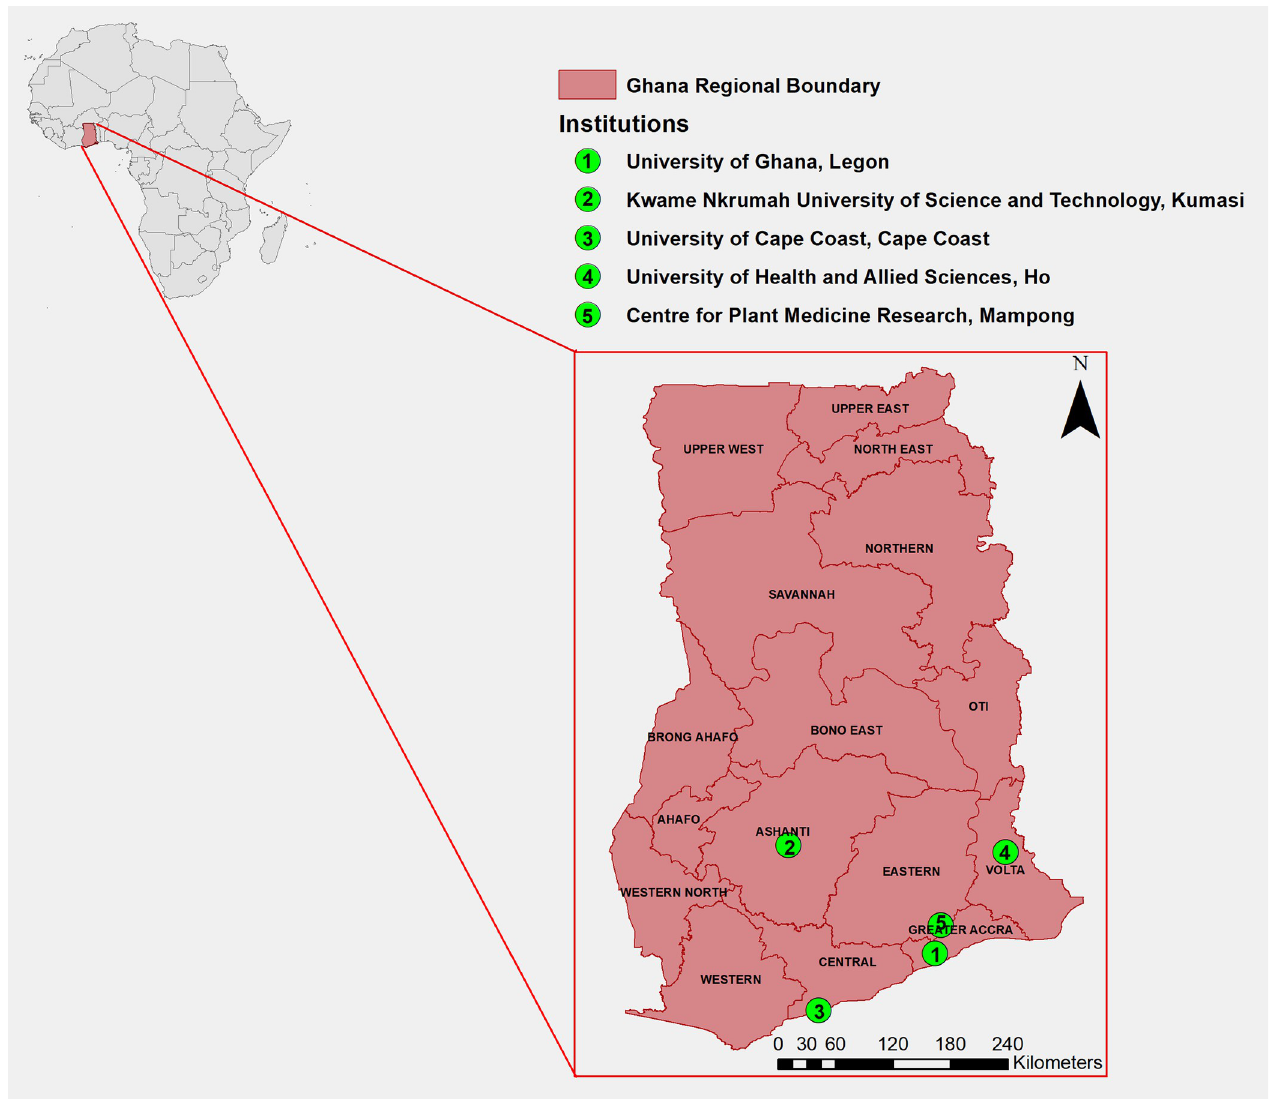
Fig 2. Universities and Institutes with an interest � in drug discovery in Ghana. � This was determined based on publications in drug discovery and through records of collaborations across the institutions. The base map used for constructing the map as well as the copyright information for use of the base map files are freely available at https://data.humdata.org/dataset/cod-ab-gha. No changes were made to the base map